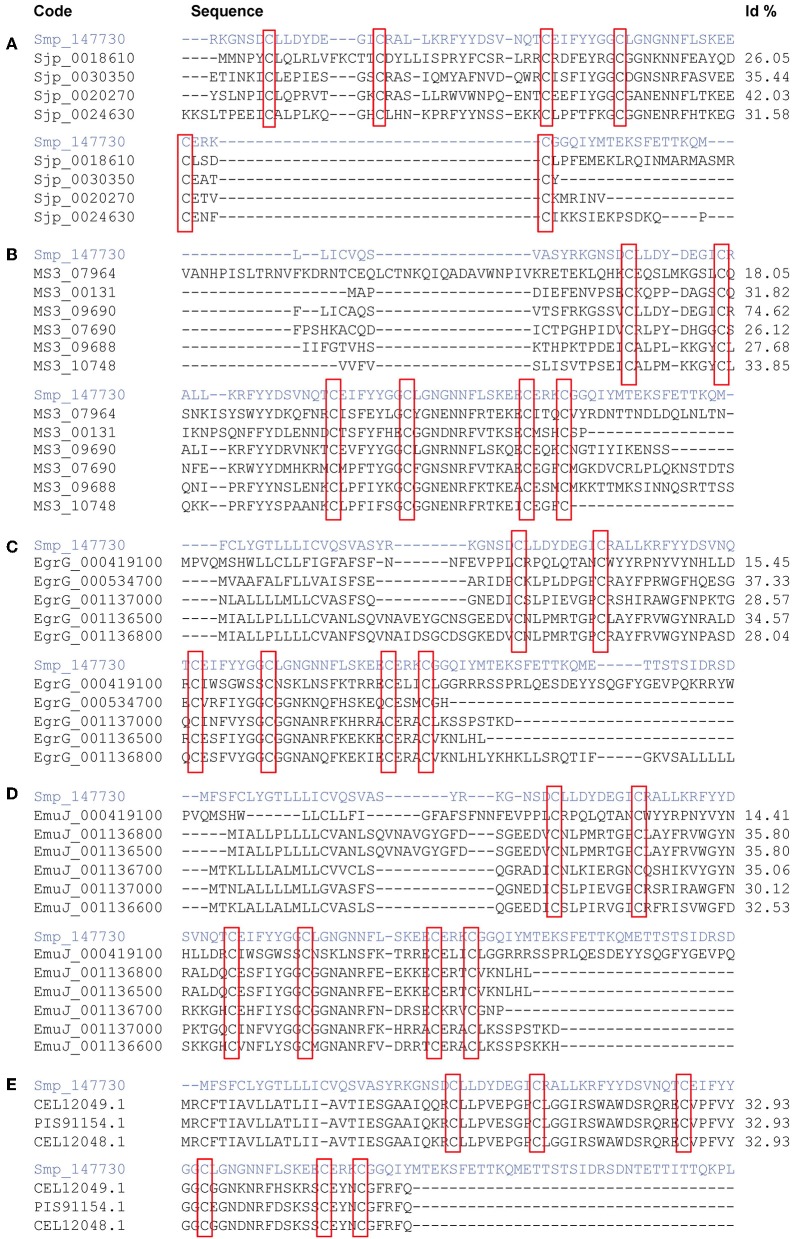
Comparison of sequence Smp_147730 (Syn. Smp_311670) from Schistosoma mansoni in a multiple sequence alignment with kunitz-type proteins from S. japonicum
(A), S. haematobium
(B), Echinoccocus granulosus
(C), E. multilocularis
(D), and Fasciola hepatica
(E). Kunitz domain positions are highlighted in red boxes.